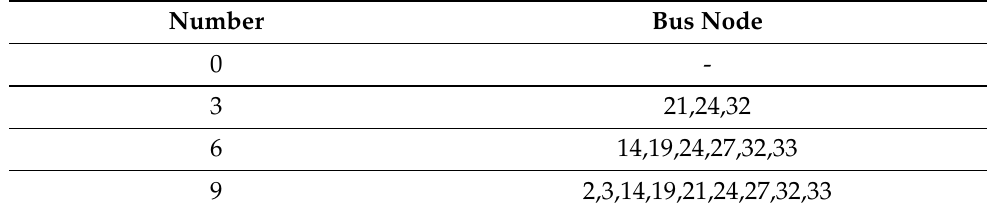
Figure 7. W 1 of voltage magnitude with different DG units. Table 2. The bus with DG unit in the IEEE 33-bus